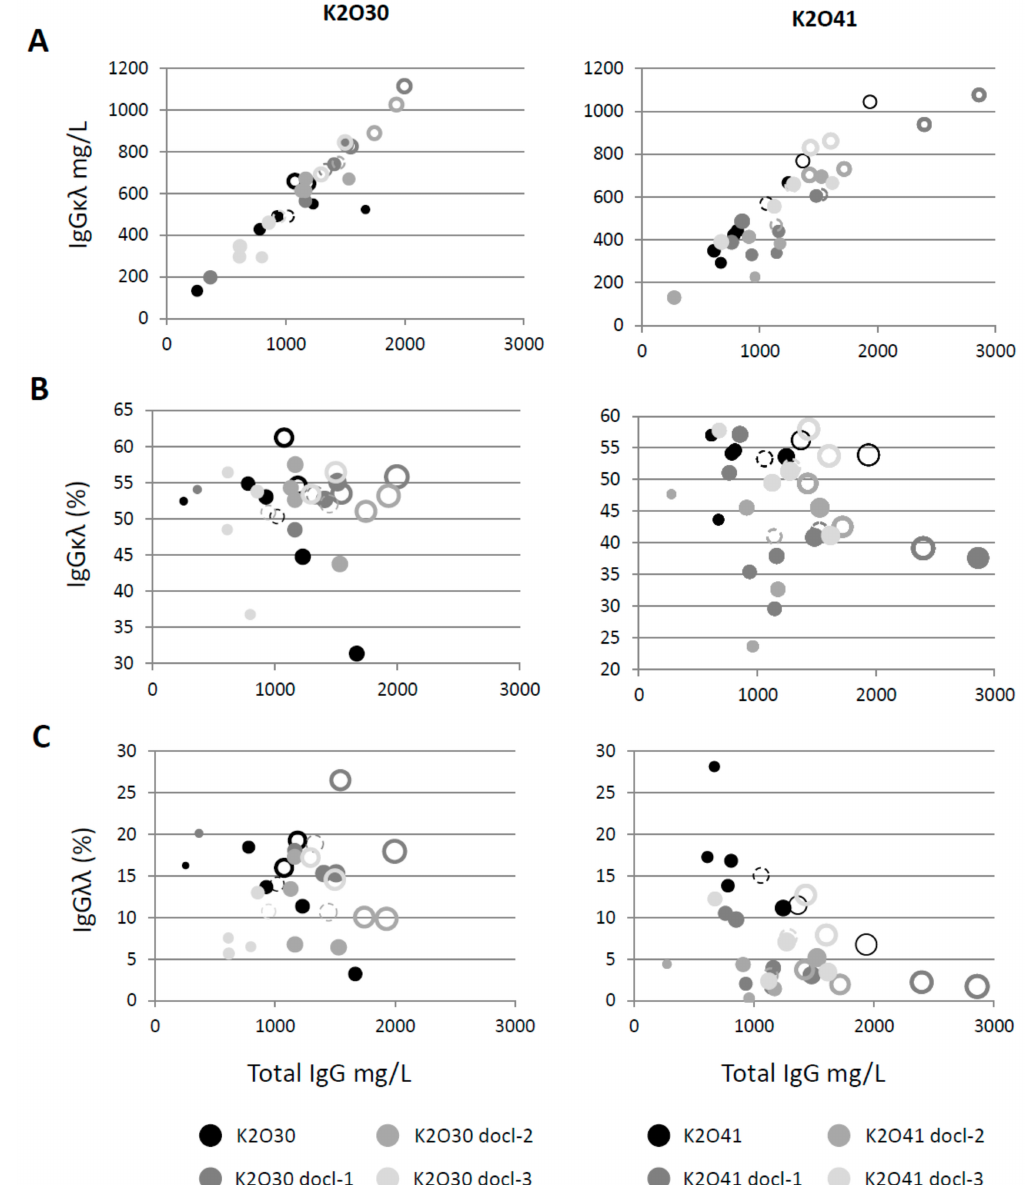
Figure 4. Representation of different parameters analyzed in the supernatants of stable CHO pools K2O30, K2O41 and their respective codon de-optimized variants. ( A ) Correlation between total IgG and IgG κλ titers. ( B ) Representation of total IgG titers, abundance of IgG κλ and IgG κλ titers. ( C ) Representation of total IgG titers, abundance of IgG λλ and IgG κλ titers. In B and C the size of the circles corresponds to the IgG κλ titer. Open circles correspond to the pools represented by open symbols in Figure 3. Circles in dotted lines correspond to the average of all pools for a given